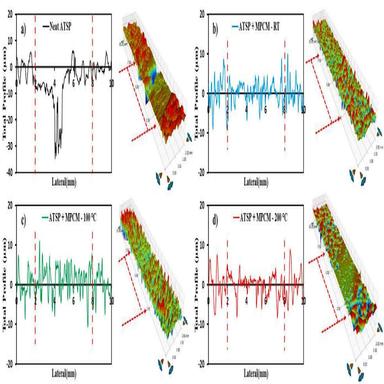
2D and 3D profilometric scans following tribological experiments of (a) neat ATSP at RT, and ATSP + MPCM at (b) RT, (c) 100 ◦C, and (d) 200 ◦C.